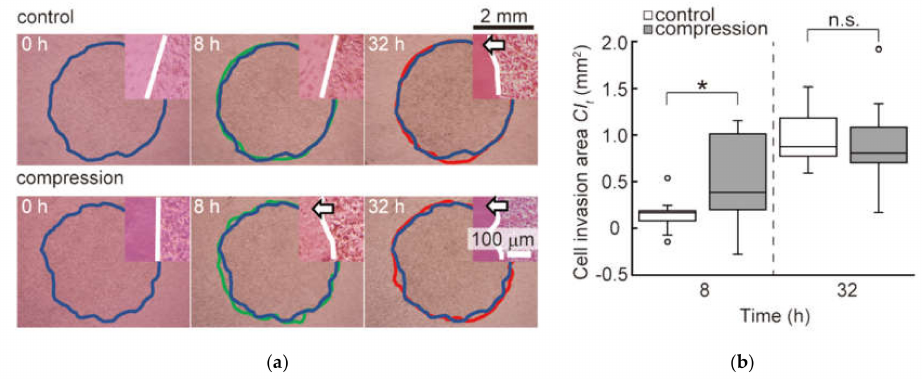
Figure 3. Invasion of B16F10 cells in the melanoma static compression model: ( a ) Microscopic images of B16F10 cells in control and compression groups. The migration of cells subjected to compressive stress was compared to control groups at each time point. The blue lines indicate the cell-adhered area at 0 h of culture, the green lines indicate one at 8 h of culture, and the red lines indicate one at 32 h of culture. The upper right images show the boundary region between the cell-adhered area and the collagen gel, with the white lines marking the boundary. The white arrows indicate the invasion of B16F10 cells into the collagen gel; ( b ) The cell invasion area ( CI t ) at each time (n = 13). Experimental data were examined for significant di ff erences using Welch’s t -tests. * indicates a significant di ff erence compared to control group ( p <